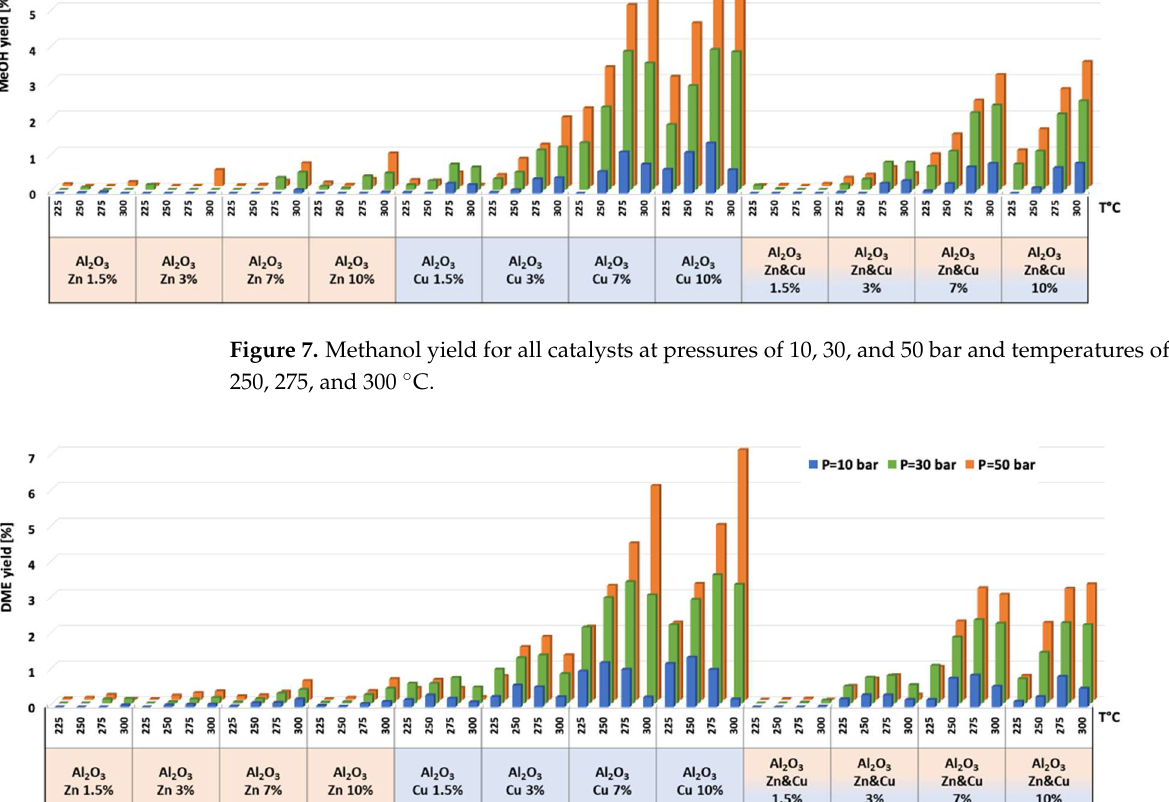
Figure 8. DME yield for all catalysts at pressures of 10, 30, and 50 bar and temperatures of 225, 250, 275, and 300 °C.